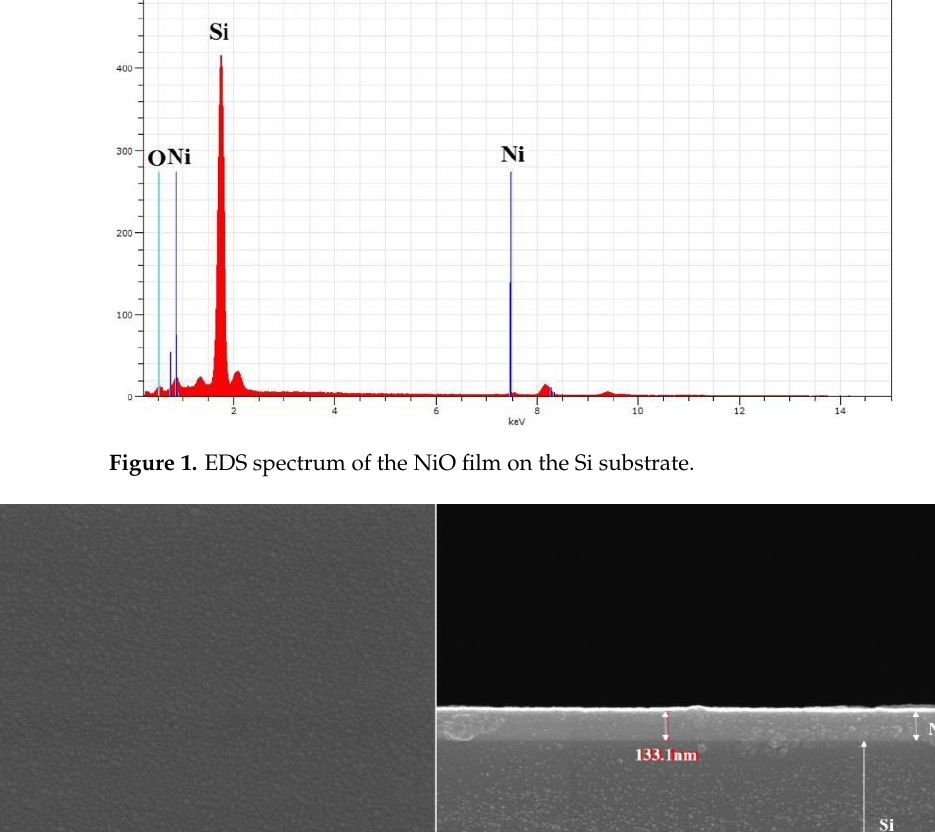
Figure 2. FE-SEM ( a ) top view and ( b ) cross-section images of the NiO film on the silicon substrate.